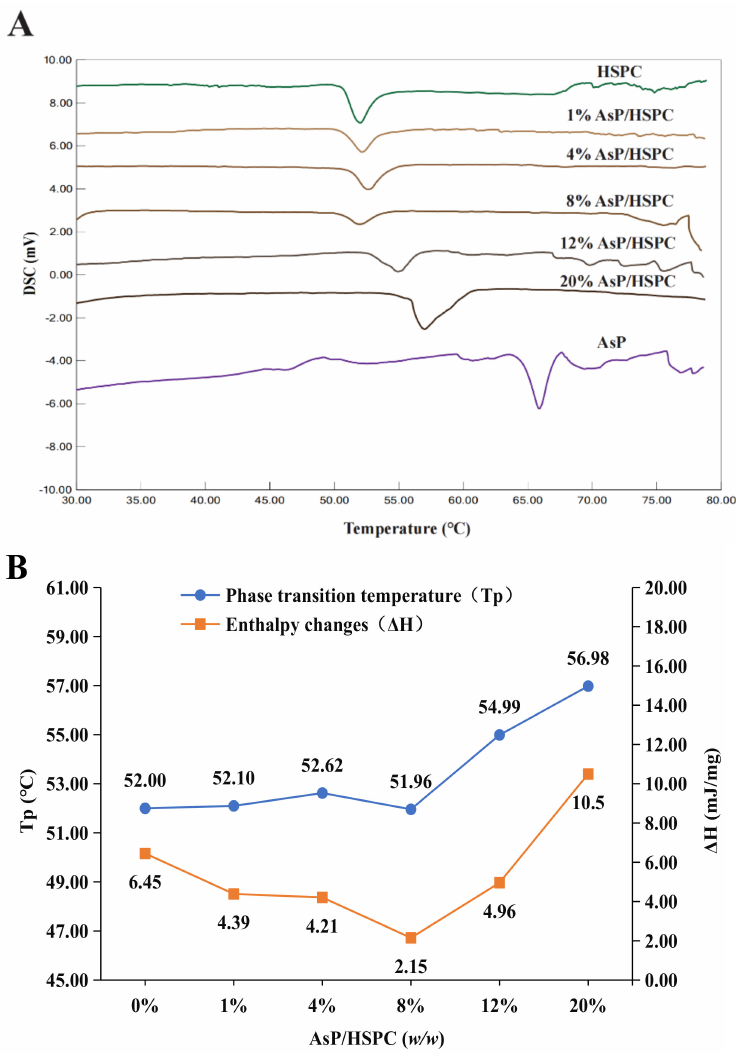
Figure 4. ( A ) DSC thermograms of AsP–PC hydrates with various AsP/HSPC ratios ( w/w ); ( B ) the main phase transition temperatures (Tp) and enthalpy changes ( ∆ H) of AsP–PC